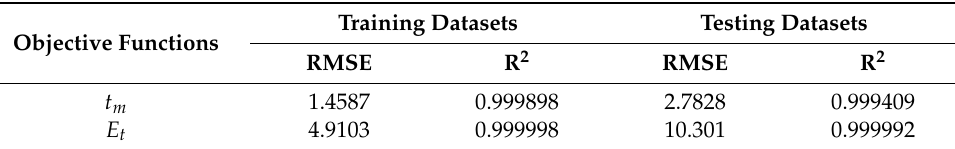
Table 5. Amount of RMSE and R 2 for t m and E t .